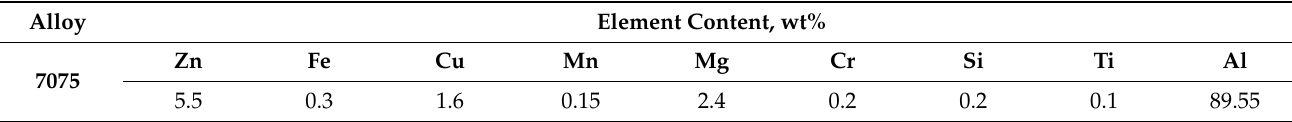
Table 1. Chemical composition of 7075 aluminum alloy.